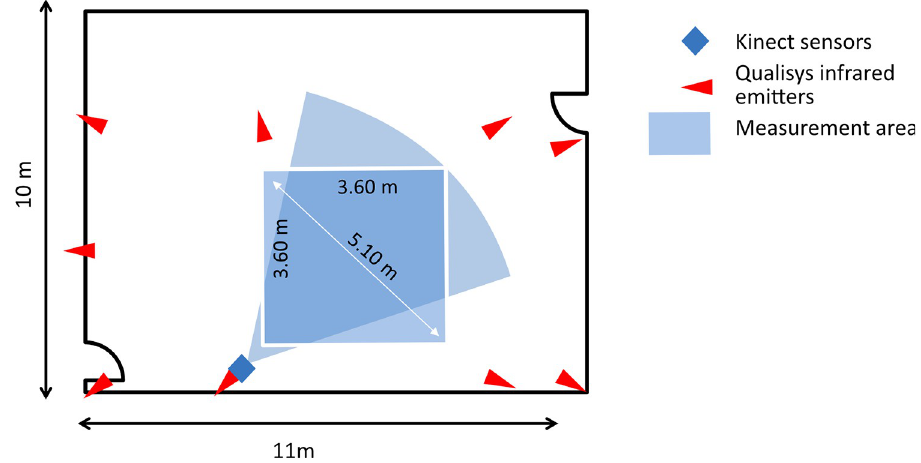
Fig 1. Measurement setup incl. positions of Qualisys Oqus cameras and Kinect sensors.